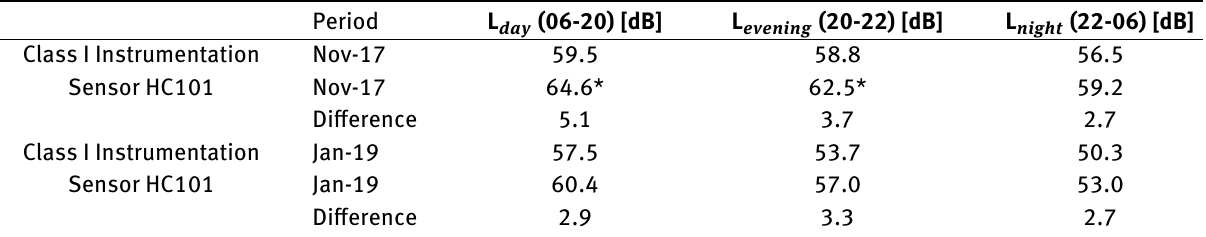
Table 2: Analysis of the results obtained for the acoustic descriptor L day , L evening and L night by the low-cost sensors and class I systems